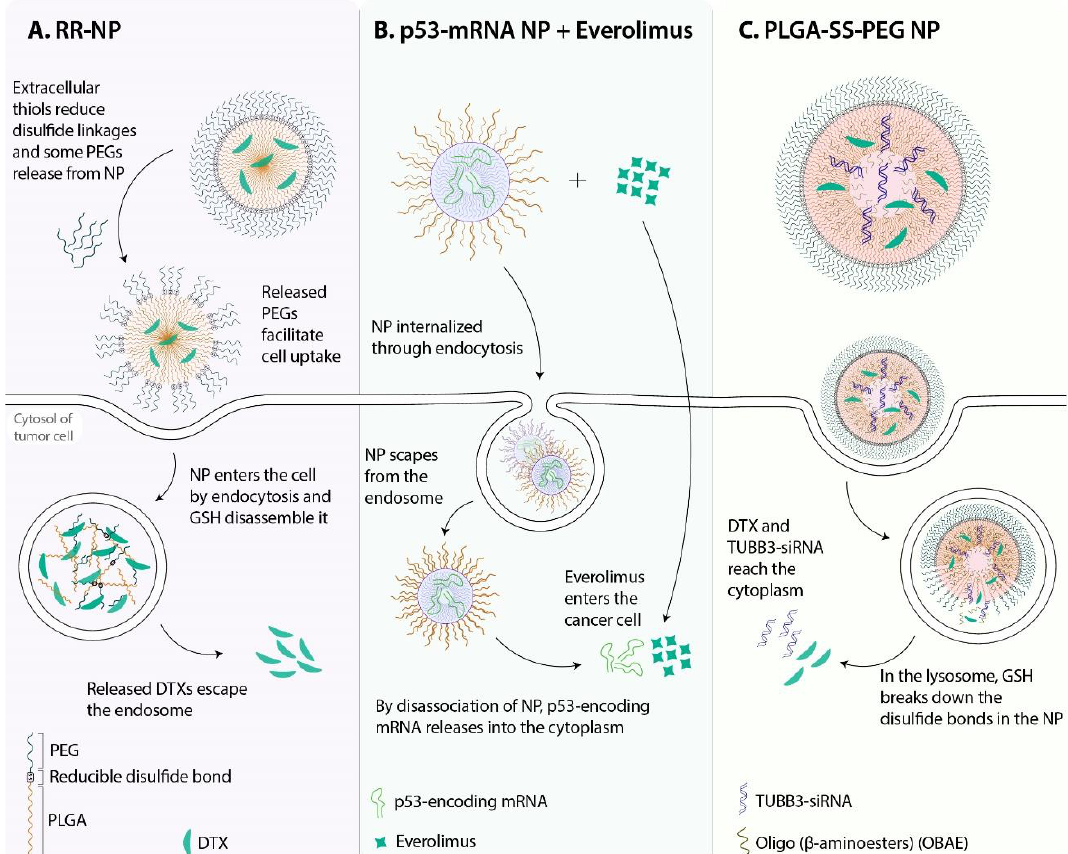
Figure 7. Redox-responsive NPs. Various nanoplatforms have been developed to deliver anticancer agents into cancer cells. ( A ) RR-NP is a polymeric NP designed to carry DTX selectively into tumor cells. ( B ) Redox-responsive NPs can be used to deliver nucleic acid anticancer agents to tumor tissues. The p53-mRNA NP is a nanocarrier that delivers p53-encoding synthetic messenger RNA (mRNA). P53-null tumor cells that receive p53-encoding genes become sensitive to everolimus (a mammalian target of rapamycin (mTOR) inhibitor). A combination of p53-mRNA NP and everolimus showed efficient antitumor function against NSCLC. ( C ) PLGA-SS-PEG NP is a spherical nanoformulation with a size of approximately 150 nm. This redox-responsive NP is developed for codelivery of DTX and TUBB3 siRNA. The NP enters the cell by endocytosis, and in the lysosome, GSH induces breakage of the disulfide bonds and disassembly of the NP. Consequently, DTX and TUBB3 siRNA escape from the lysosome and perform their anticancer activity in the cytosol.